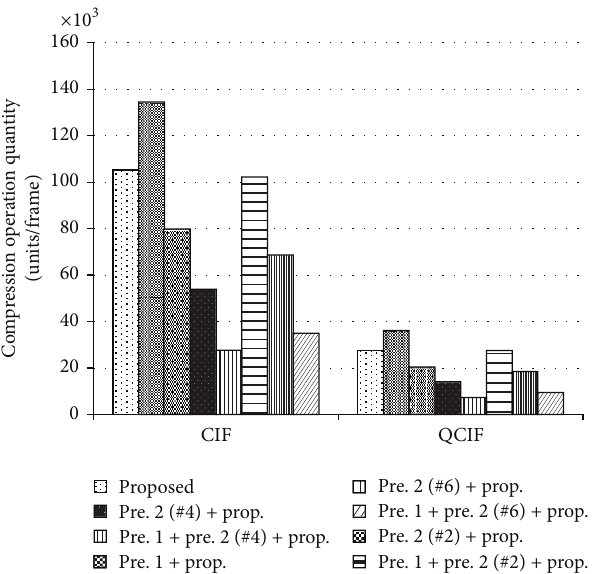
Figure 10: Compression operation quantity with preprocessing